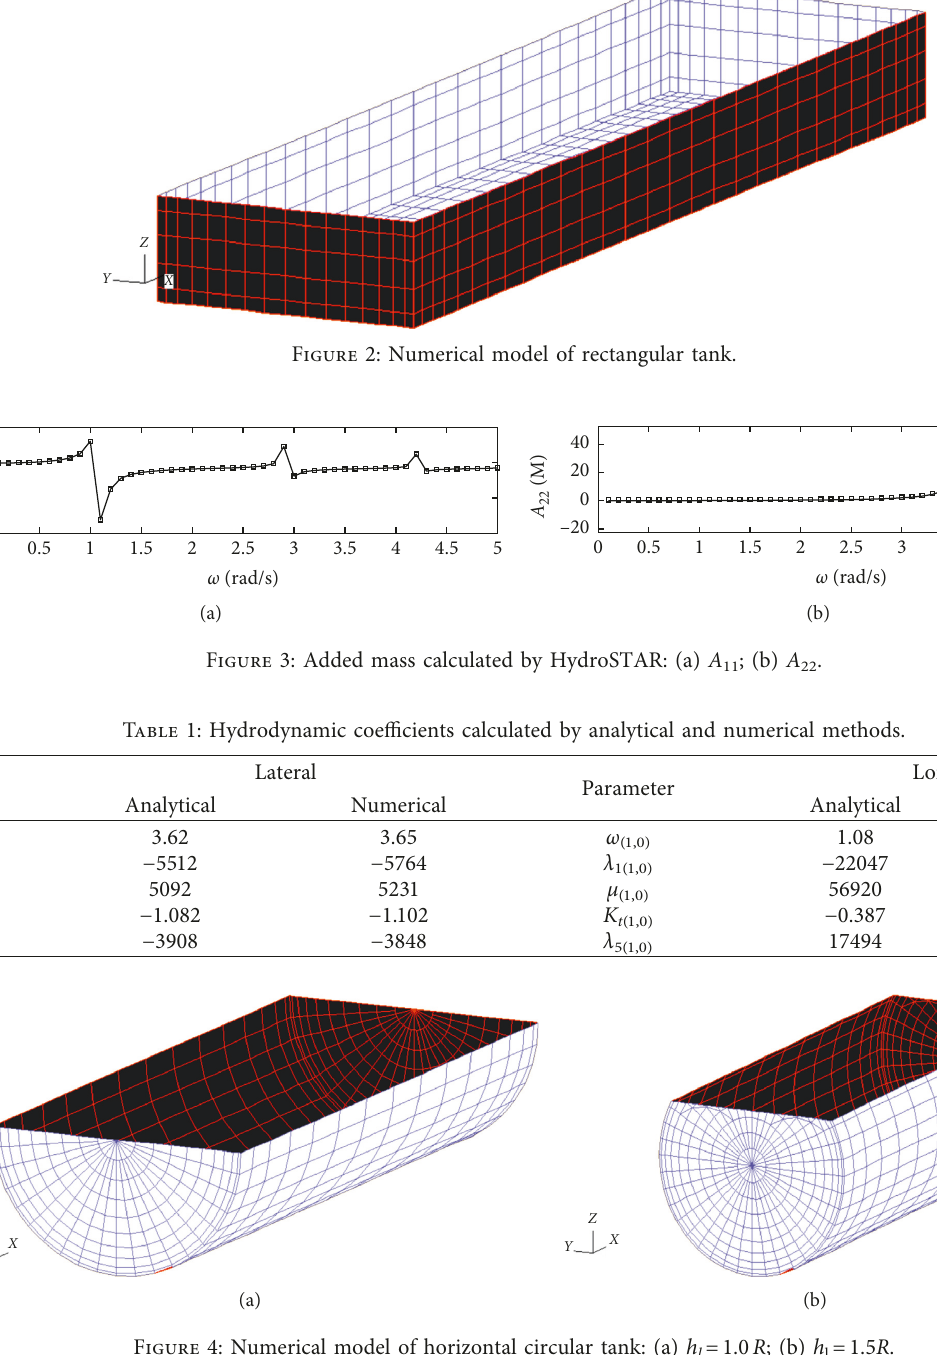
� 1.0 R ; (b) h � 1.5 R l l